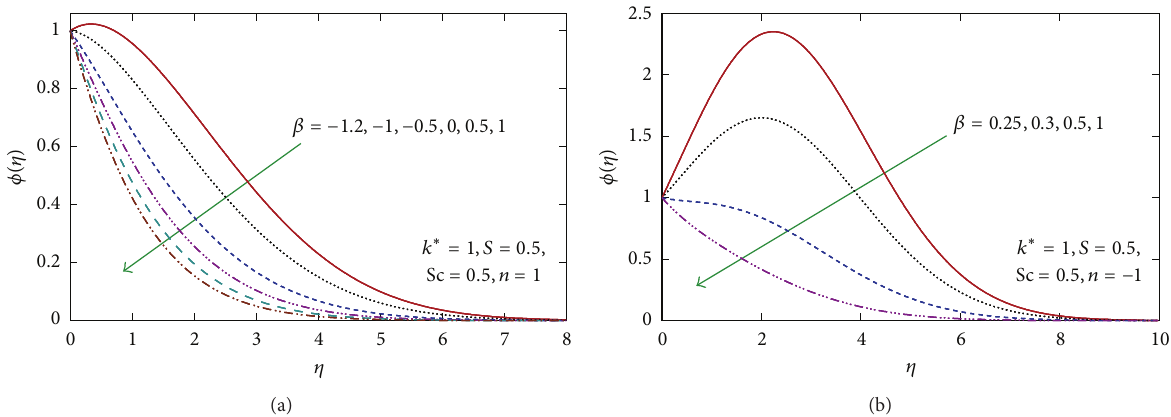
Figure 7: (a) Concentration profiles 𝜙(𝜂) for different values of 𝛽 with 𝑛 > 0 . (b) Concentration profiles 𝜙(𝜂) for different values of 𝛽 with 𝑛 < 0 .